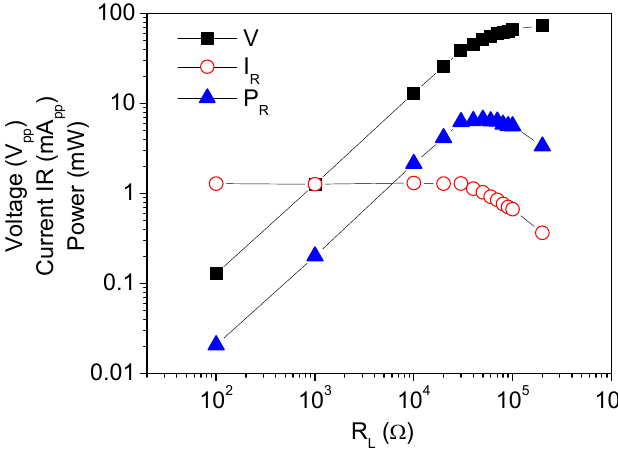
Figure 8. Output performance of the energy harvester under a 500 Ω load as a function of the input voltage to the transducer.